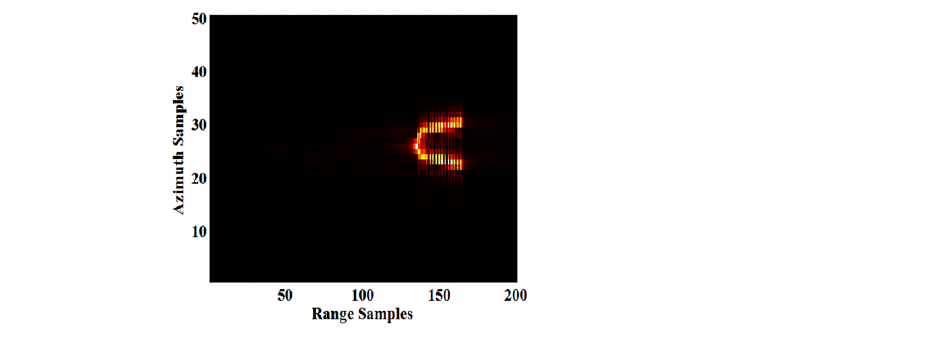
Figure 20. ISAR image of the hypersonic target without considering the plasma sheath.